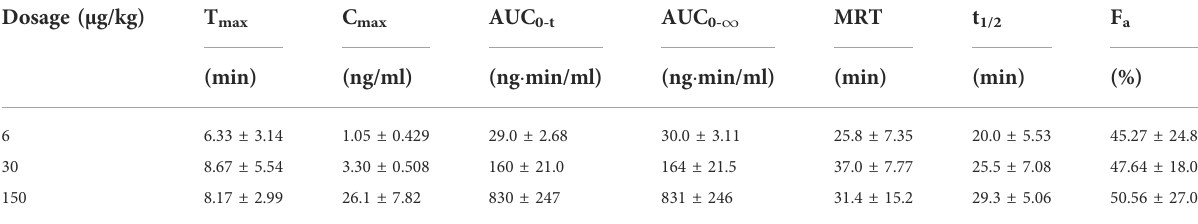
TABLE 5 Pharmacokinetic parameters of BPC157 in dogs following intramuscular administration of doses ranging between 6 and 150 μ g/kg (mean ± SD, n = 6). Dosage ( μ g/kg)